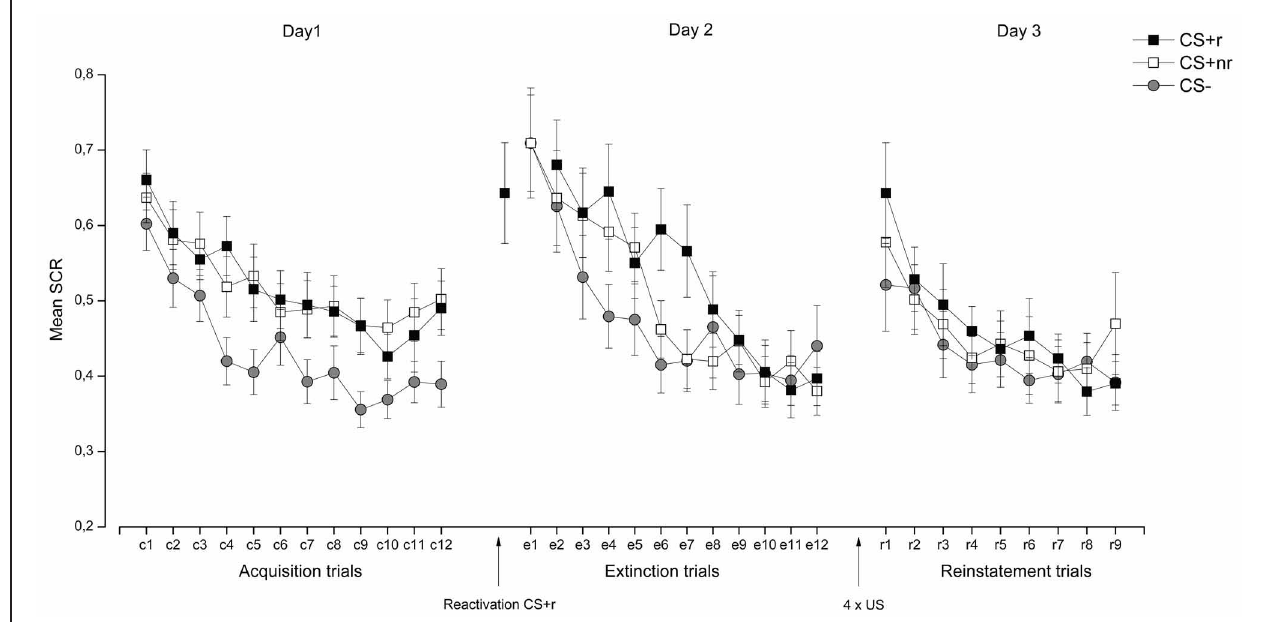
testing. Contrary to the findings by Schiller et al. (2010), we did not observe an effect of fear memory reactivation (CS + r) prior to extinction learning in SCR. Error bars represent standard error of the mean